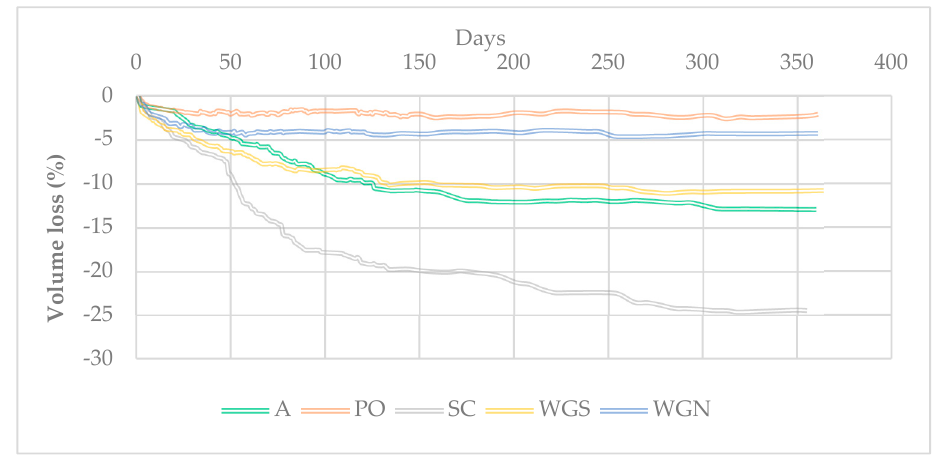
Figure 5. Volume loss (%) of the mortars.